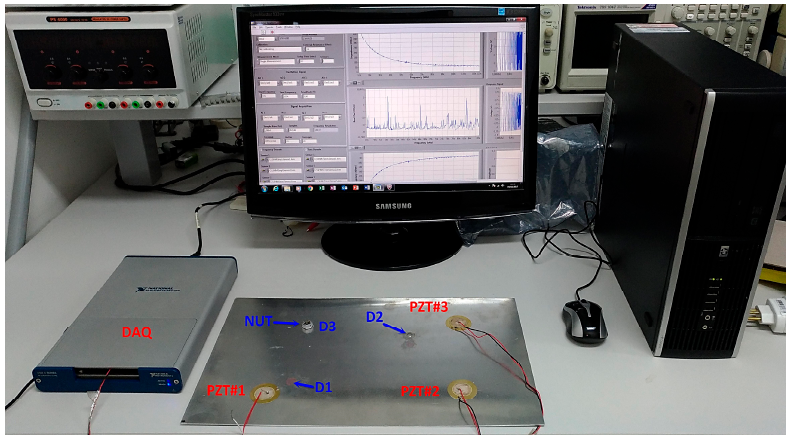
Figure 6. Experimental apparatus including: the aluminum plate, containing three PZT patches, DAQ, and computer running the acquisition